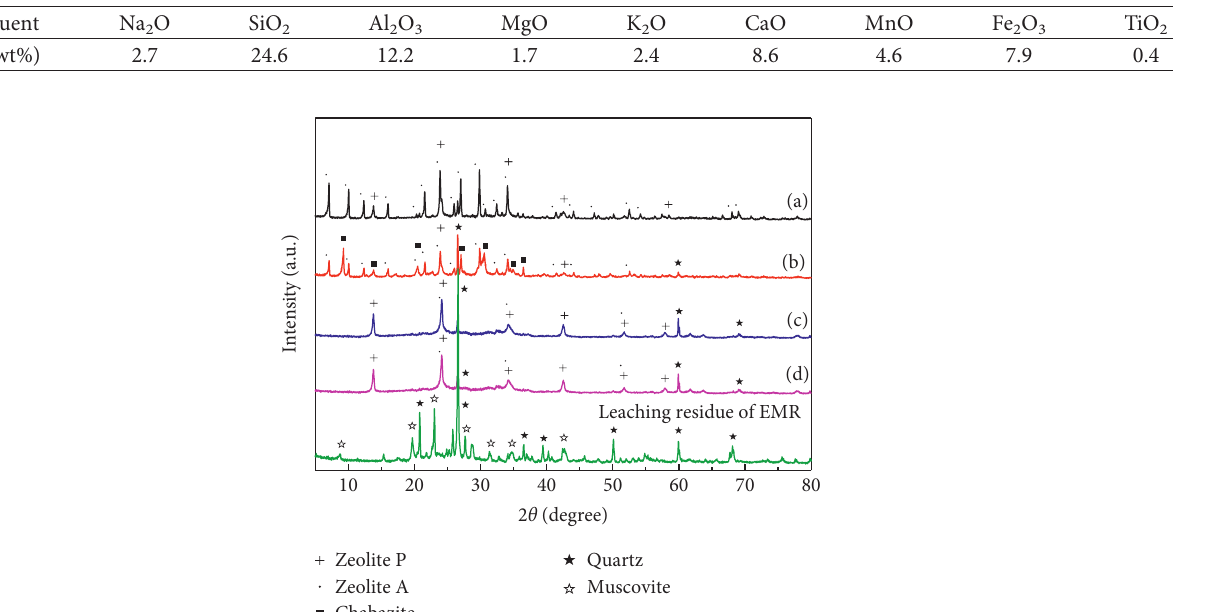
Table 1: Major chemical composition in EMR.